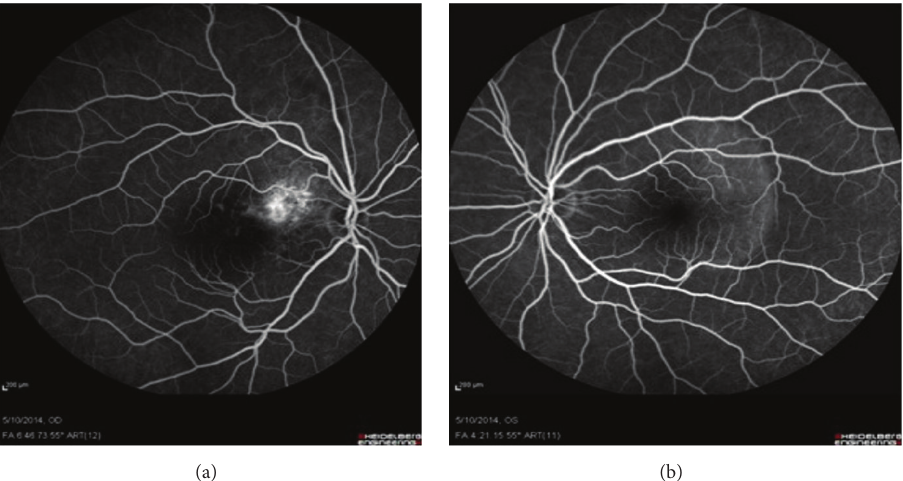
Figure 3: FAG; hyperfluorescent area in the right eye is CNV membrane, and hyperfluorescence over the mass in the left eye is window defect due to RPE and retinal